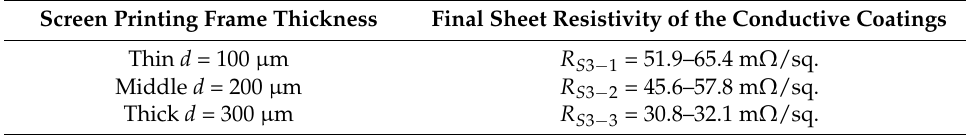
Table 5. Cu/Ag films on ceramic substrate with coated area of 2 cm × 2 cm.